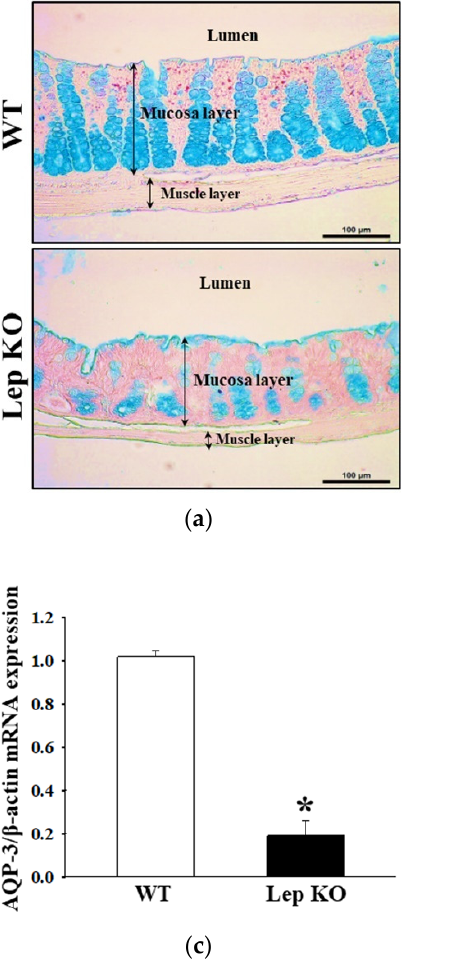
Figure 5. Mucin secretion and membrane water channel expression. ( a ) Mucin secreted from crypt layer cells was stained with alcian blue at pH 2.5. Images were observed at 400× magnification. Five to six mice per group were used in the slide section, and mucin staining was assessed in duplicate in two different slides. The levels of MUC2 ( b ), AQP3 ( c ), and AQP8 ( d ) transcripts in the total mRNA of transverse colons were measured by RT-qPCR using the specific primers. The mRNA levels of three genes were calculated based on the transcript level of β -actin as an endogenous control. Three to five mice per group were used to prepare the total RNA, RT-qPCR analyses were assayed in duplicate for each sample. The data are reported as the mean ± SD. *, p < 0.05 compared to the WT group. Abbreviations: WT, Wild type; KO, Knockout type; RT-qPCR, Quantitative real time-PCR; MUC2, Mucin 2; AQP, Aquaporin.